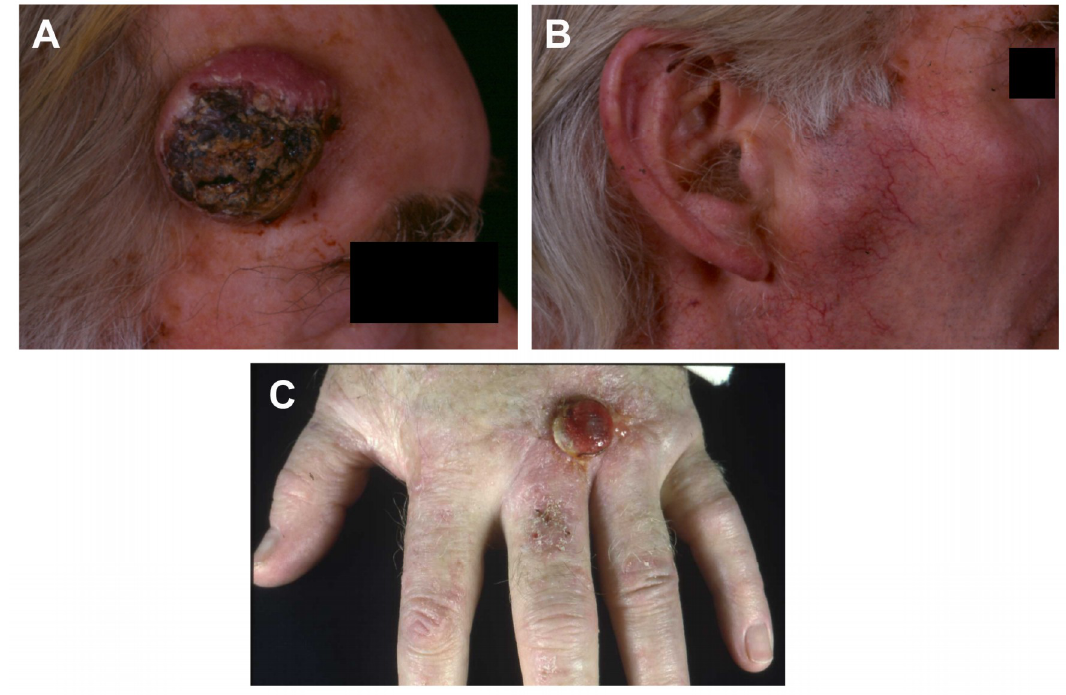
Figure 1. Clinical presentation. Primary cutaneous squamous cell carcinoma (cSCC) on the temple of an immunocompetent male which gave rise to the IC1 cell line ( A ). Lymph node metastasis which gave rise to the IC1MET cell line ( B ) . Local recurrent cSCC on the hand of an immunosuppressed male transplant recipient, giving rise to the MET2 cell line ( C ).